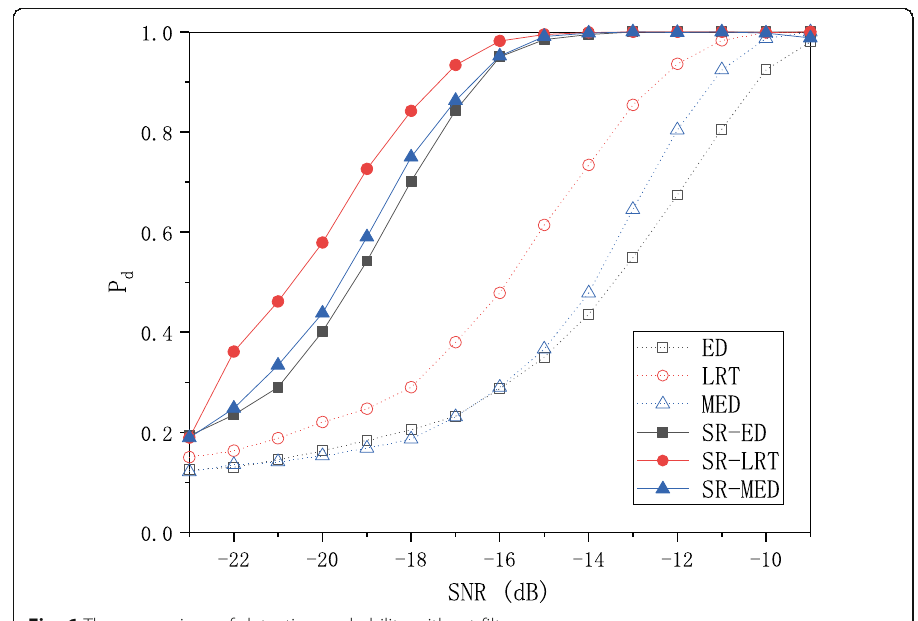
Fig. 6 The comparison of detection probability without filters